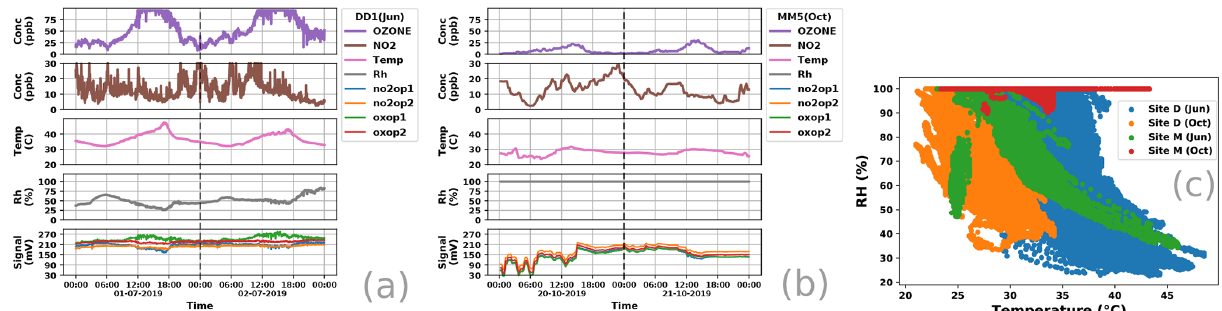
Figure 2. Panels (a, b) present time series for raw parameters measured using the reference monitors (NO 2 and O 3 concentrations) as well as those measured using the SATVAM LCAQ sensors (RH, T , no2op1, no2op2, oxop1, oxop2). Panel (a) considers a 48h period during the June deployment (1–2 July 2019) at site D with signal measurements taken from the sensor DD1 whereas (b) considers a 48h period during the October deployment (20–21 October 2019) at site M with signal measurements taken from the sensor MM5 (see Sect. 2.3 for conventions used in naming sensors e.g., DD1, MM5). Values for site D are available at 1min intervals, while those for site M are averaged over 15min intervals. Thus, the left plot is more granular than the right plot. Site D experiences higher levels of both NO 2 and O 3 as compared to site M. Panel (c) presents a scatterplot showing variations in RH and T at the two sites across the two deployments. The sites offer substantially diverse weather conditions. Site D exhibits wide variations in RH and T levels during both deployments. Site M exhibits almost uniformly high RH levels during the October deployment which coincided with the retreating